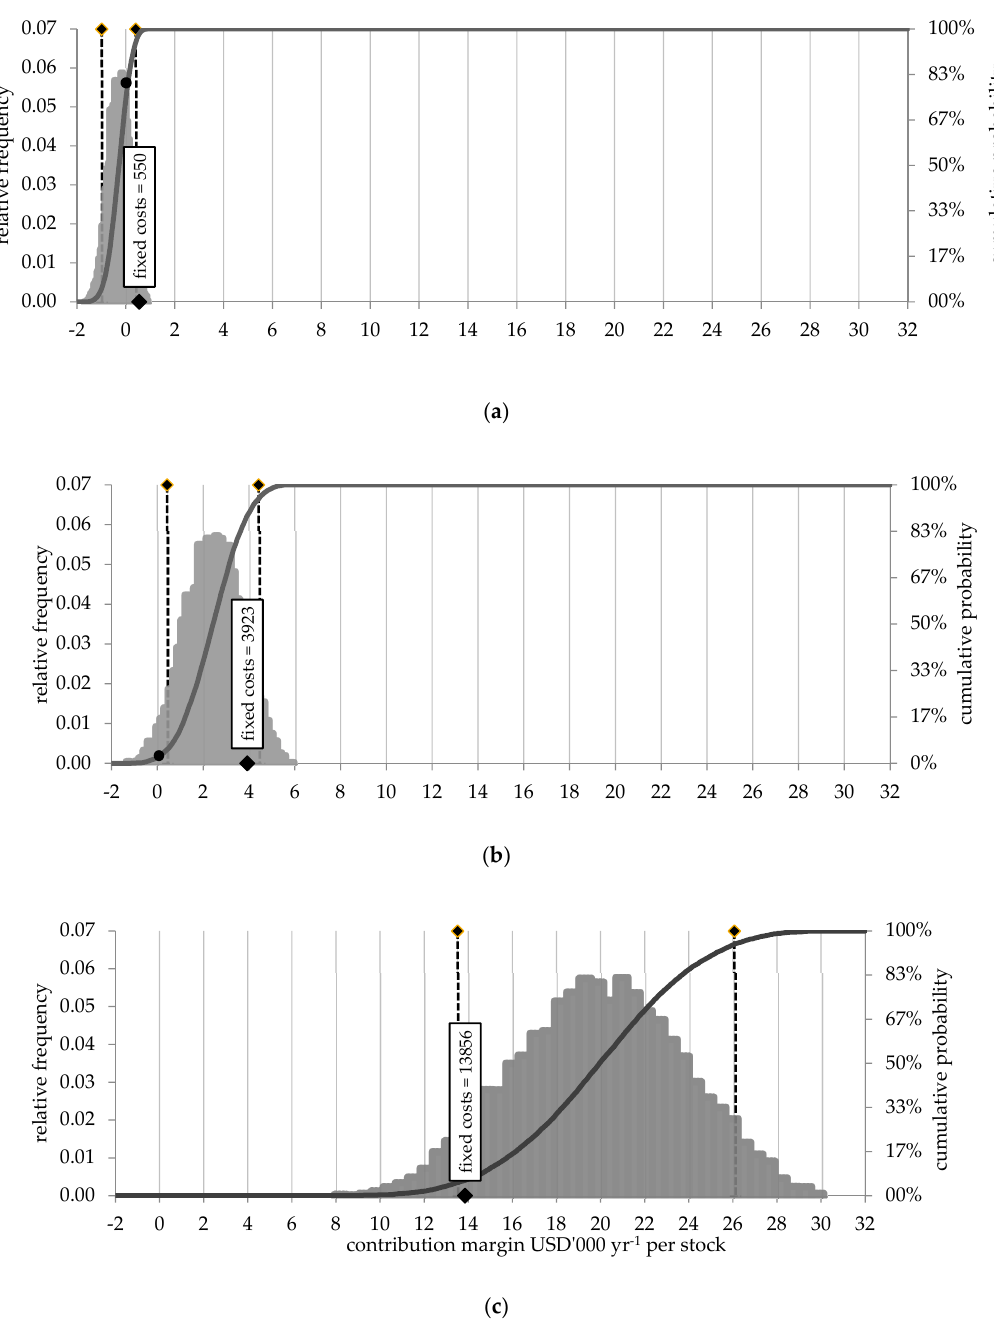
Figure 4. Relative frequencies (histograms) and cumulative probabilities (curves) of contribution margin for worst case scenario based on Monte Carlo simulation with 10,000 iterations: ( a ) small-scale, ( b ) medium-scale, and ( c ) large-scale type of individual farms. Vertical dashed lines indicate 90% of relative frequencies. Points ( ● ) on cumulative probability curves indicate contribution margin of zero and a 74% (a) and 3% (b) risk that revenues cannot cover variable costs. Rhombuses ( ⧫ ) mark total fixed costs.